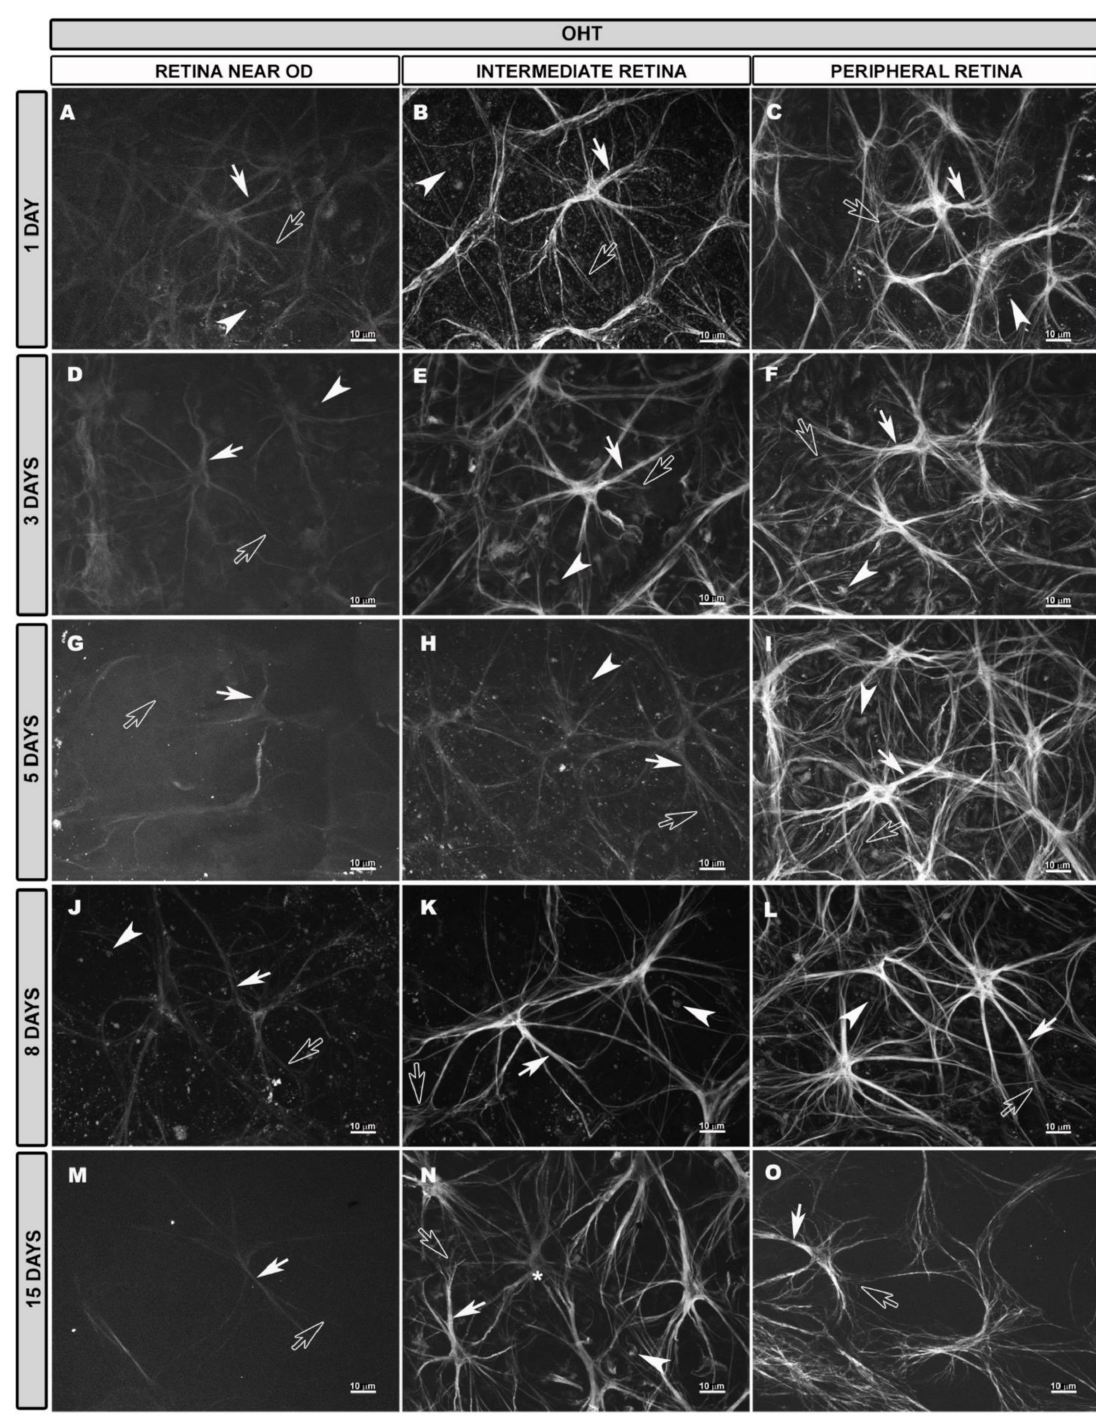
Figure 5. Retinal whole-mount. GFAP immunostaining at different times after OHT induction in eyes with OHT (high magnification). Morphological characteristics of macroglial cells in eyes with OHT at 1, 3, 5, 5, 8 and 15 days after laser treatment ( A – O ). Astrocytes near the optic disc (OD) had low GFAP immunoreactivity, and only soma and primary processes (white arrow) were visualized at 1 ( A ), 3 ( D ), 5 ( G ) 8 ( J ) and 15 ( M ) days after laser treatment. In the intermediate retina, astrocytes